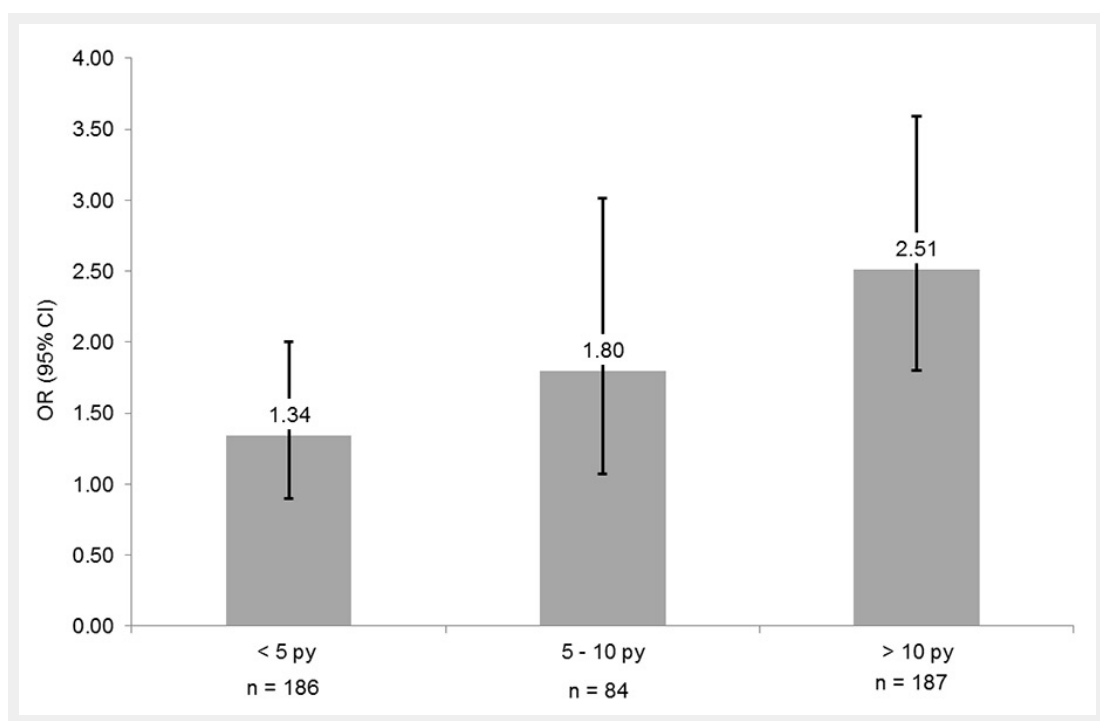
Figure 2 Relationship of pre-diabetes with cumulative smoking exposure. Never smokers represent the reference group. Boxes indicate odds ratios, whiskers are 95% confidence intervals. Data are adjusted for age, sex, Body Mass Index, hypertension, alcohol consumption, education, low density lipoprotein and high density lipoprotein cholesterol, physical activity, fruit/vegetable consumption and body composition.